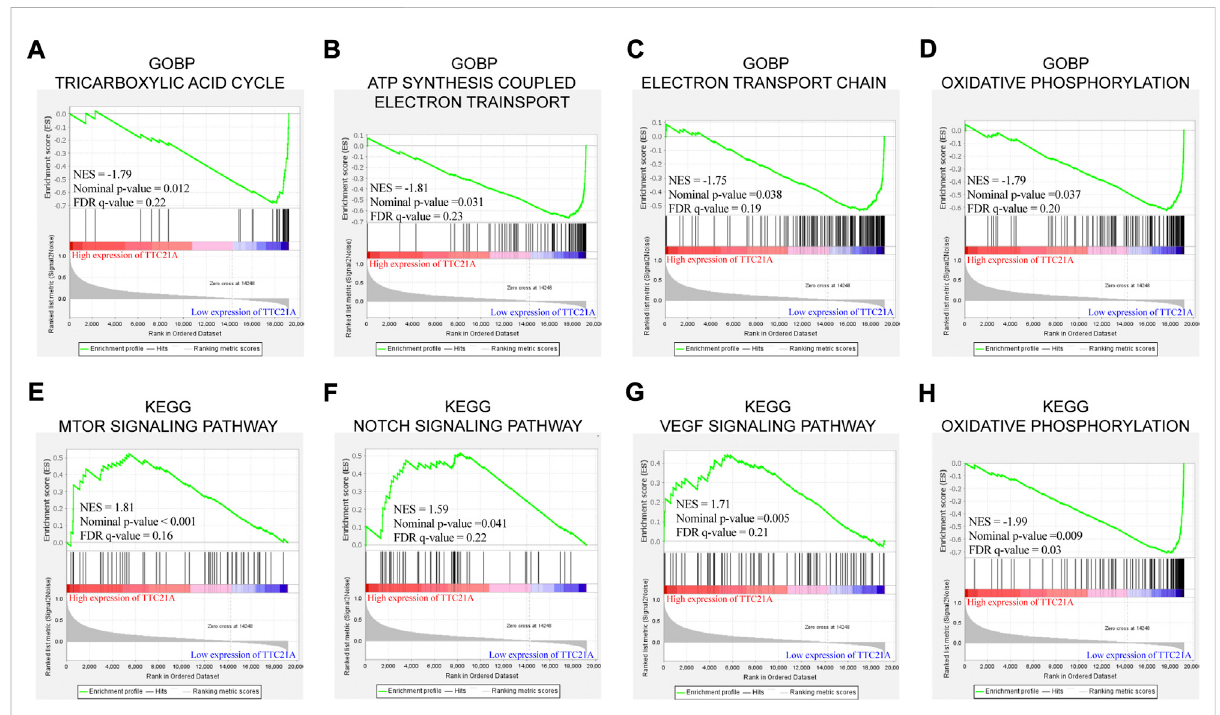
FIGURE 5 Enrichment analysis ofTTC21AinccRCC.Tricarboxylic acidcycle (A) , ATPsynthesis coupledelectron transport (B) ,electron transportchain (C) and oxidative phosphorylation (D) were enriched in biological process of ccRCC. MTOR signaling pathway (E) , NOTCH signaling pathway (F) , VEGF signaling pathway (G) and oxidative phosphorylation (H) were enriched in KEGG